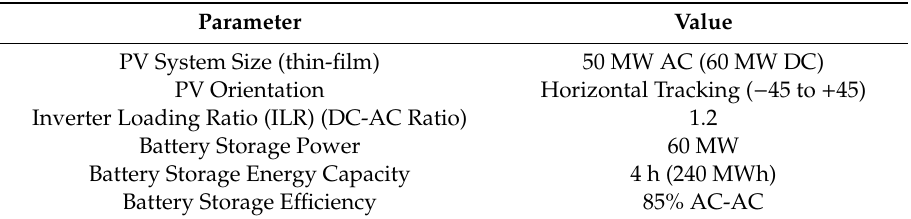
Table A2. Parameters for the PVS system analyzed in California for providing peaking capacity.